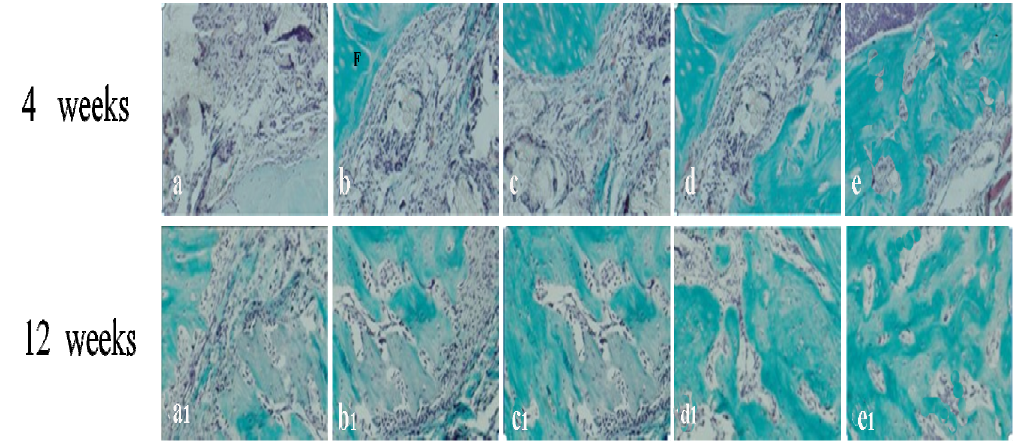
Figure 7. Tissue slices of different mandibular implants at weeks 4 and 12 stained with Masson staining. a ( a ) Scaffold alone; b ( b ) BMSCs/scaffold; c ( c 1 1 d ( d ) BMSCs/BMP-2/scaffold; e(e ) BMSCs/bFGF/BMP-2/scaffold; F, collagen fibers. 1 1